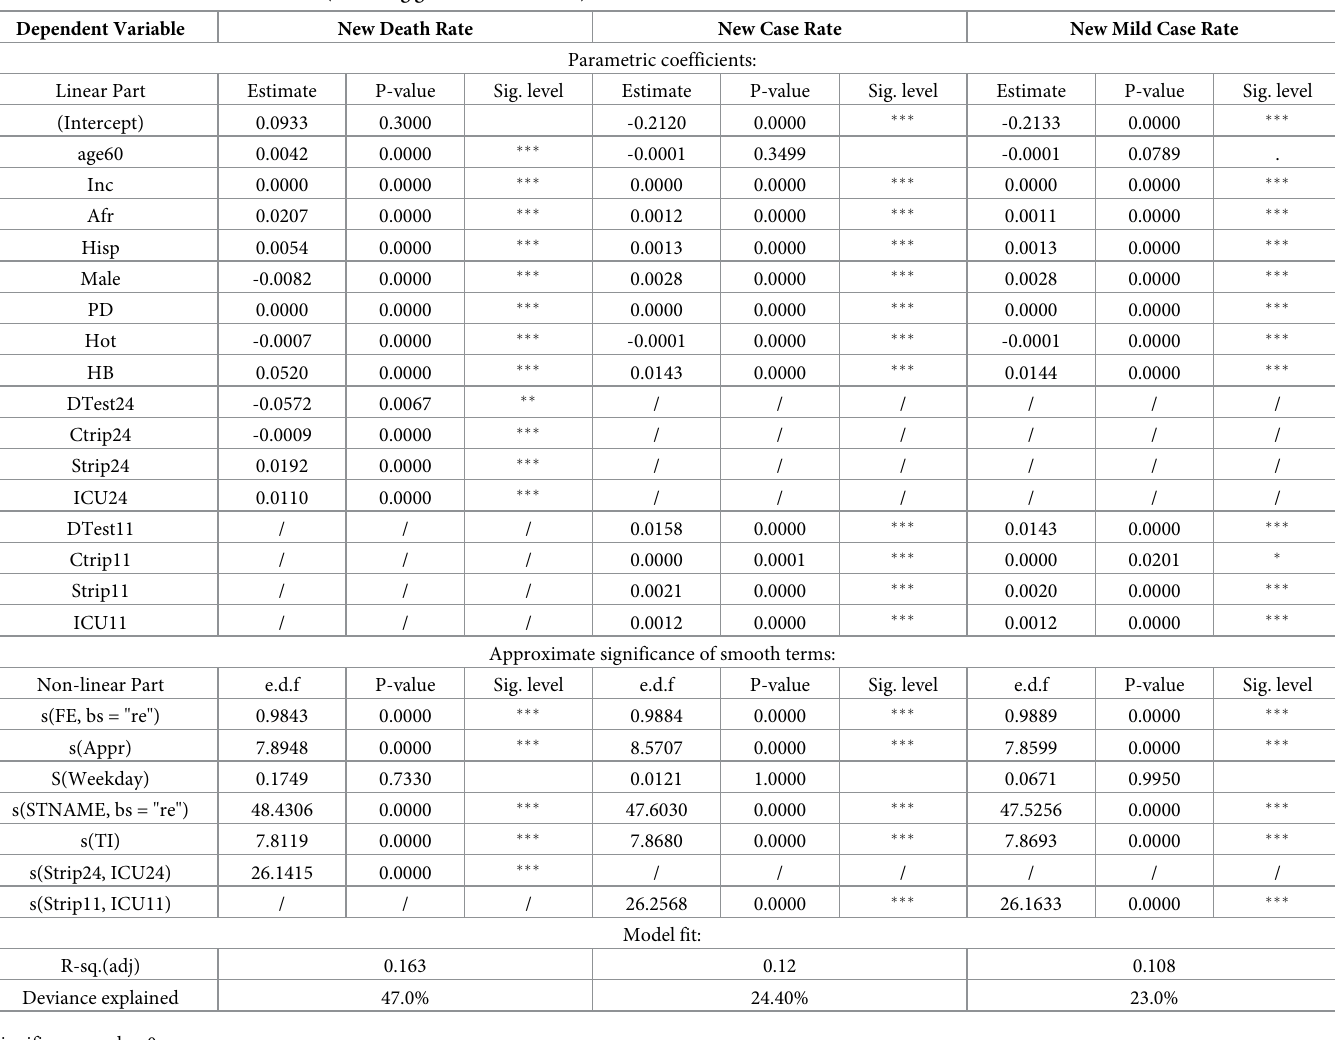
Table 3. GAM model estimation results (assuming gamma